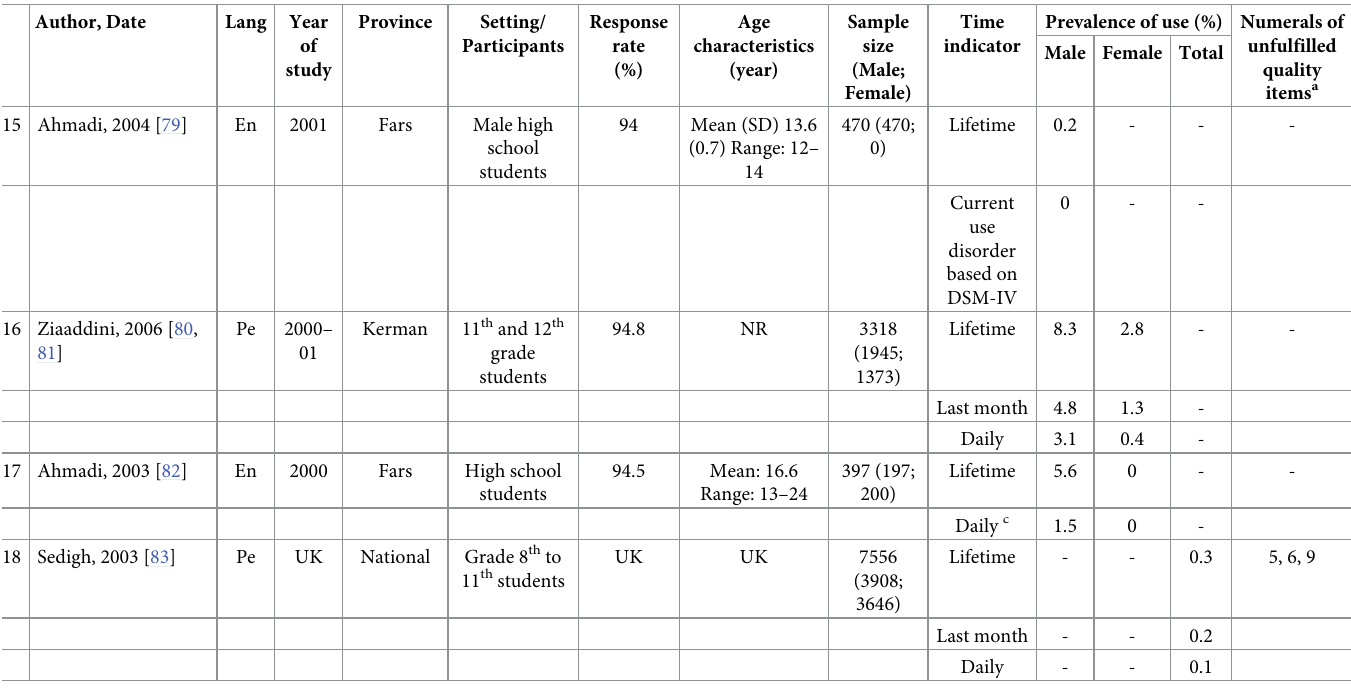
(Table 5 and S4 Fig). Three studies provided the prevalence of daily or almost daily use with the pooled estimate of 0.5% (95%CI: 0.0–1.7; I 2 = 77.8%; 3 studies) in men and 0.0%